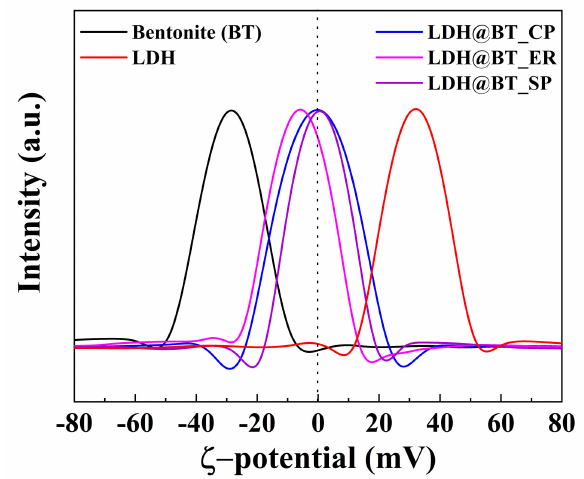
Figure 2. The zeta-potential distributions of the bentonite, LDH, LDH–BT_CP, LDH–BT_ER, and LDH–BT_SP. (dotted line indicating 0